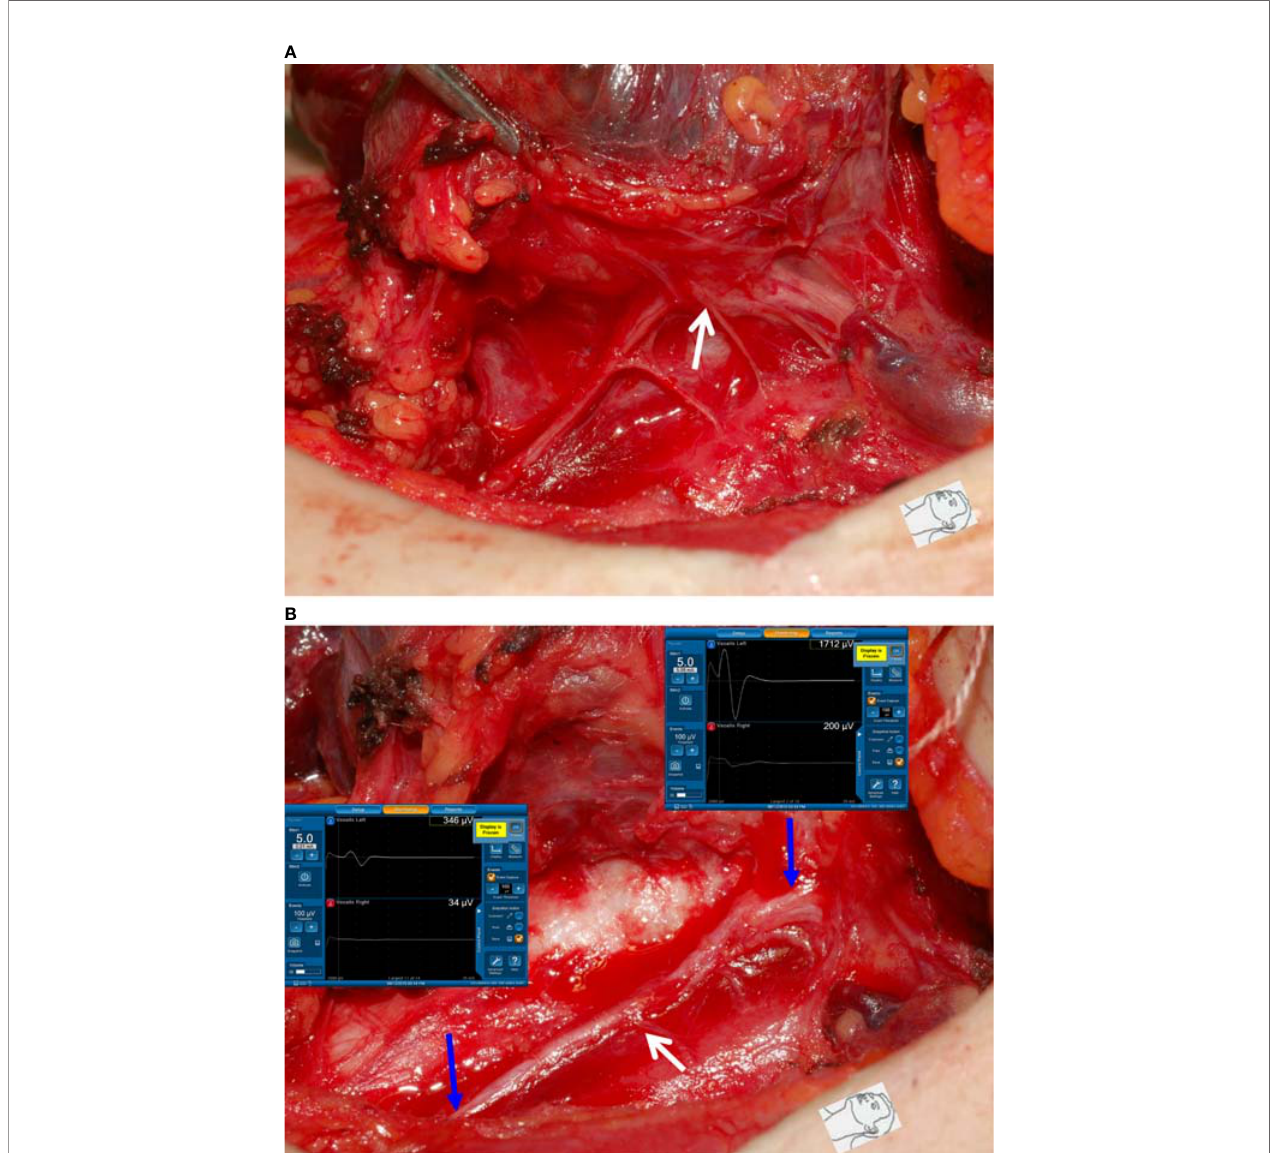
FIGURE 4 | Dissecting trauma of the RLN. (A) The RLN was adherent to thyroid cancer. (B) After complete RLN dissection and comparing R 2p signal (346 µV) with R 2d signal (1712 µV), it showed an approximately 80% amplitude reduction and an injured point caused by dissecting trauma was mapped (white arrow). The patient had temporary vocal cord